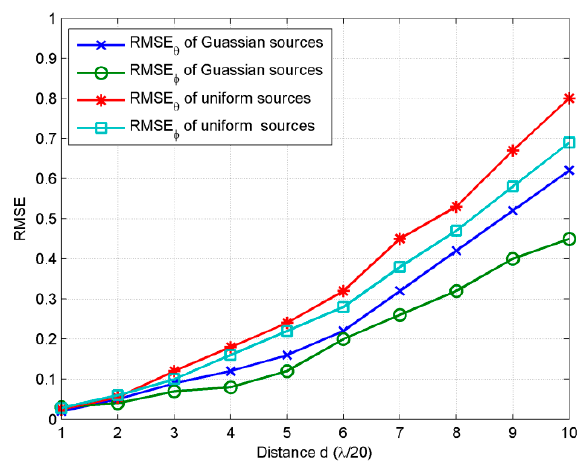
Figure 5. RMSE estimated for 2D ID sources with different distance d.